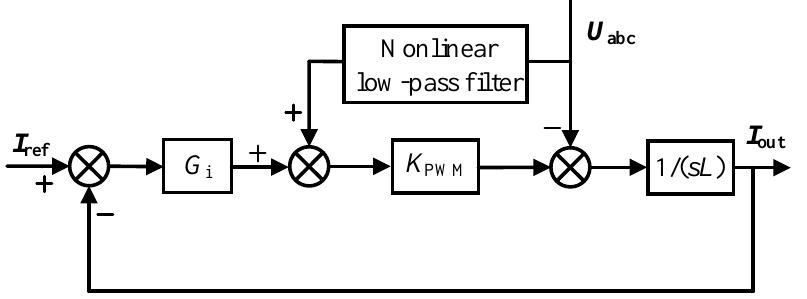
Figure 14. Simplified control diagram of MMC after adding nonlinear low-pass